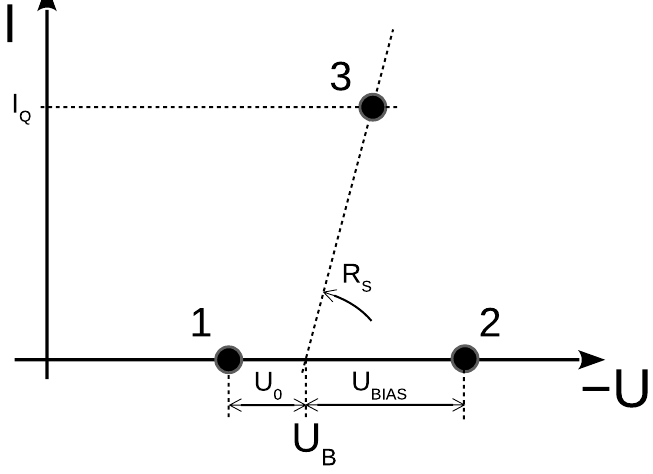
Figure 1. Current–voltage characteristic of a Single Photon Avalanche Diode (SPAD) operated in Geiger mode indicating three main states of the detection process. U breakdown